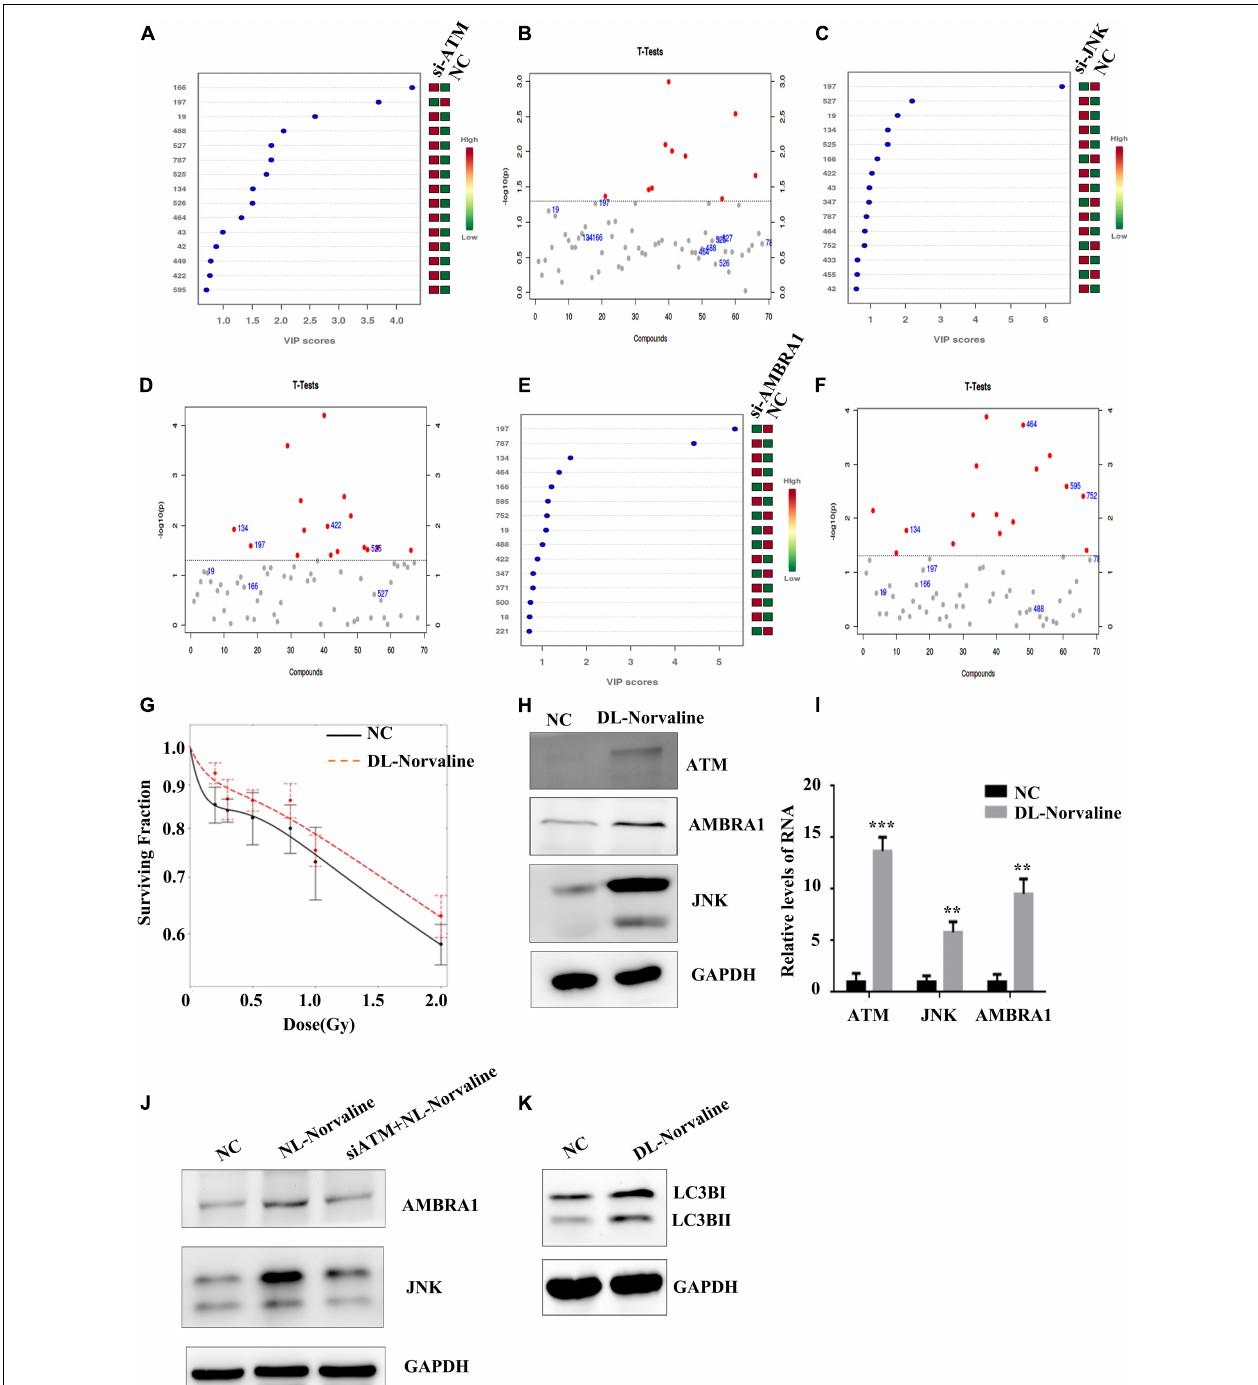
FIGURE 6 | Metabolic processes associated with the low-dose HRS phenomenon. (A,B) Differences in metabolites between the ATM-knockdown group and the control group. (C,D) Differences in metabolites between the JNK-knockdown group and the control group. (E,F) Differences in metabolites between the AMBRA1-knockdown group and the control group. (G) Effect of DL -Norvaline on the low-dose radiosensitivity of A549 cells. (H,I) Effect of DL -Norvaline on the expression levels of ATM, JNK, and AMBRA1 in A549 cells. (J) Effect of siRNA knockdown of ATM on the DL -Norvaline effect. (K) Effect of DL -Norvaline on autophagy *** p < 0.001, ** p <